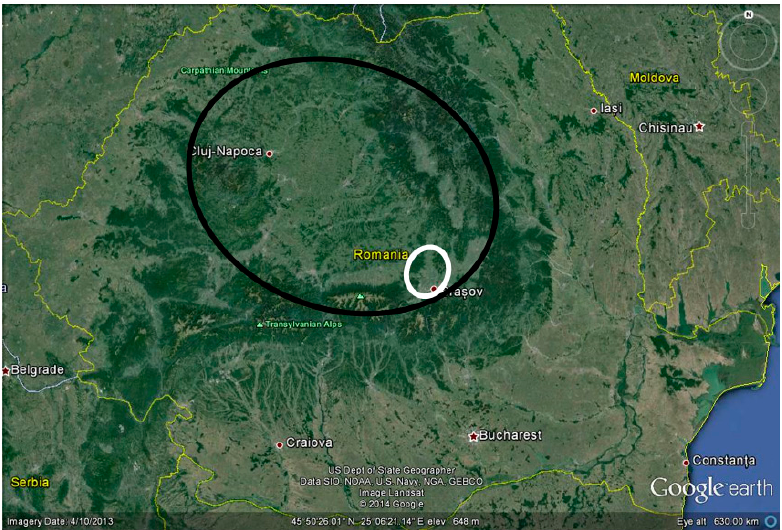
Figure 1. Studyarea. Whitecircle(Bras Figure 1. Study area. White circle (Bra ș ov depression), part of Transylvania province; black oval, ovdepression), partofTransylvaniaprovince; , Romania.